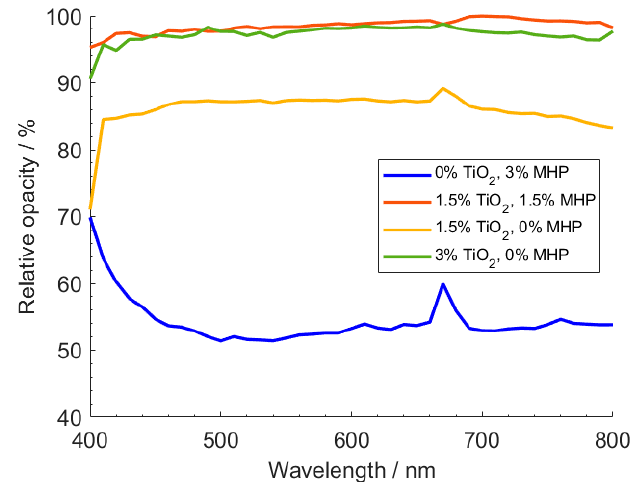
Figure 7. Variation of relative opacity with radiation wavelength for different LDPE compositions.